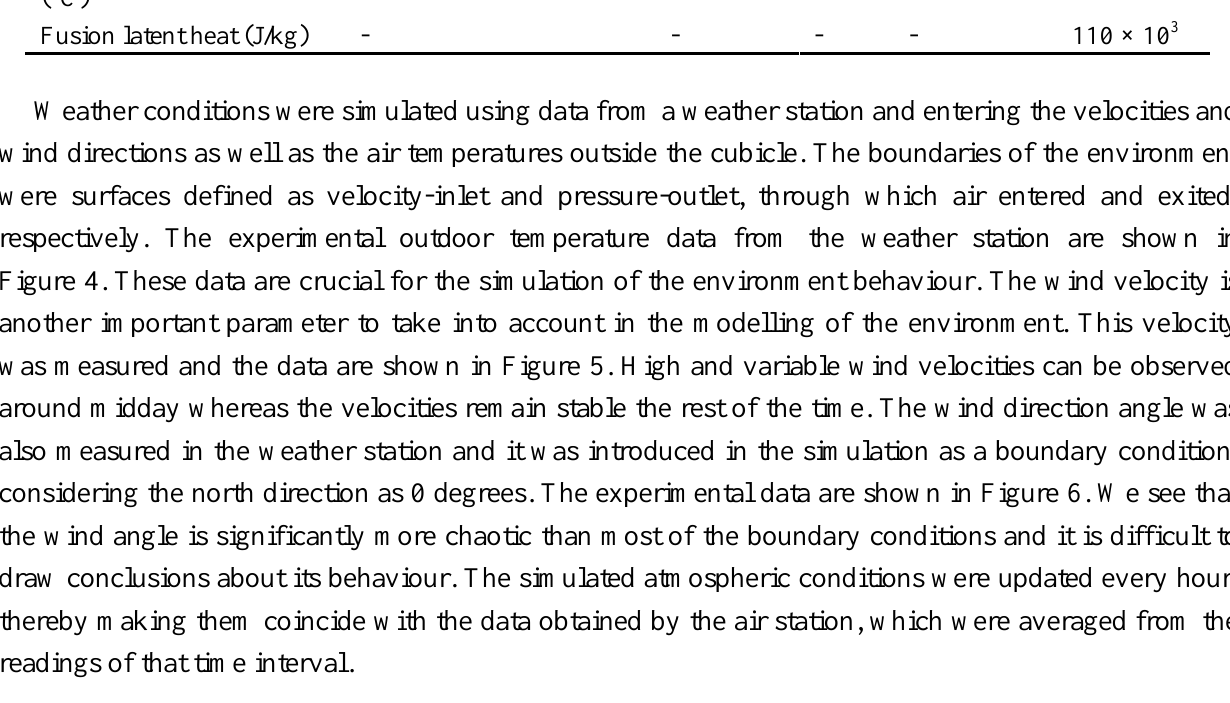
Figure 4. Outdoor temperature data measured in the weather